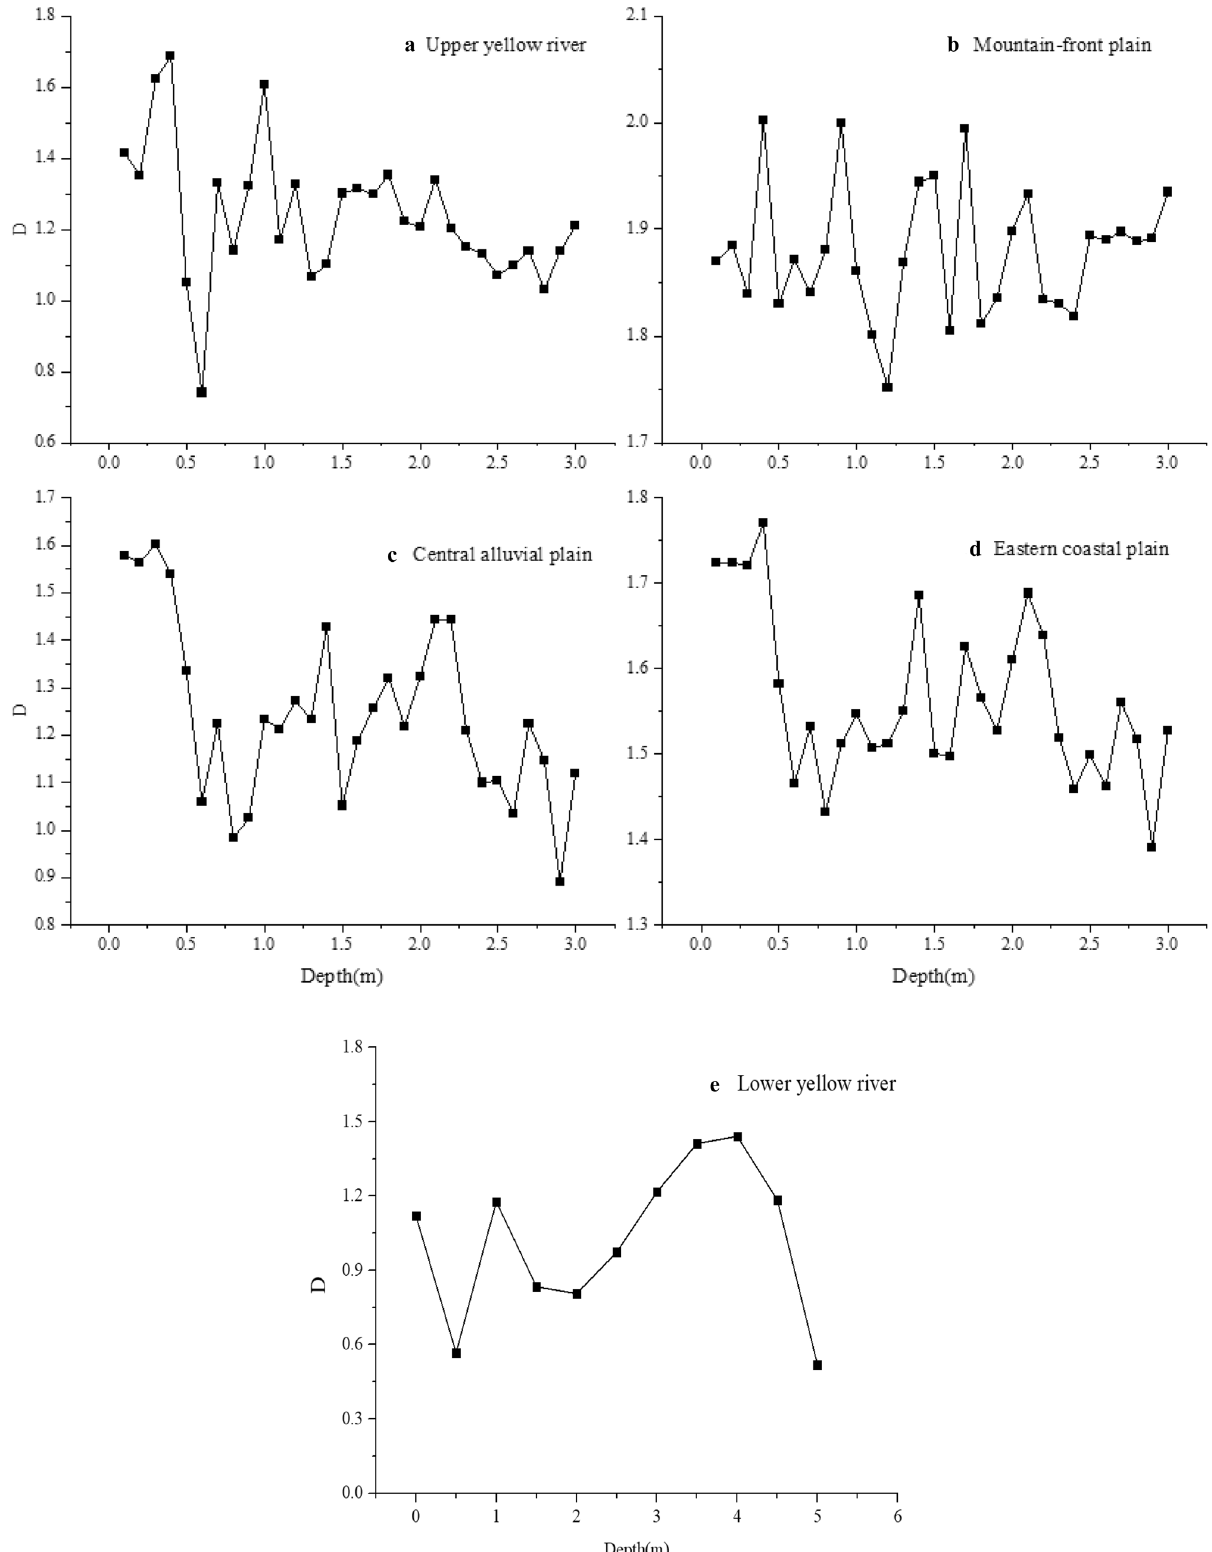
Figure 5. Characteristics of the variation of fractal dimension with